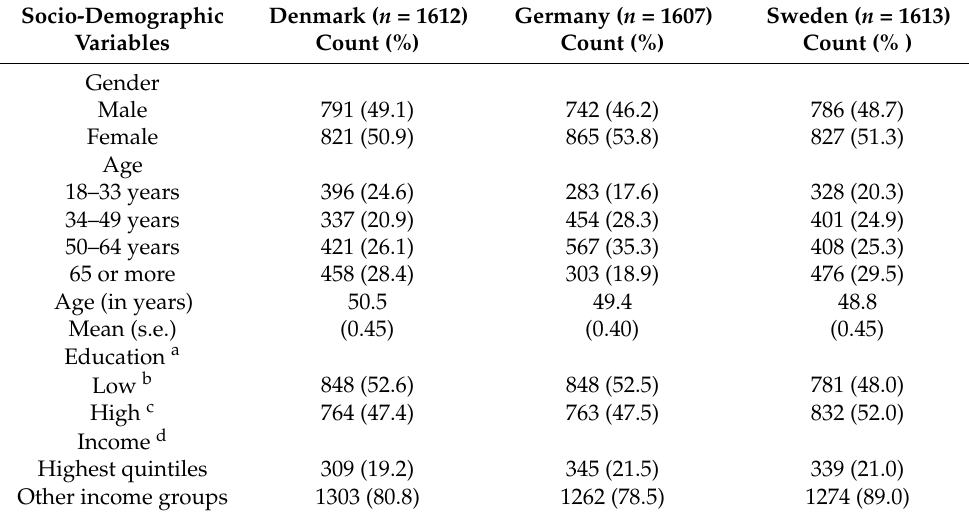
Table 1. Socio-demographic details of the three samples (unweighted